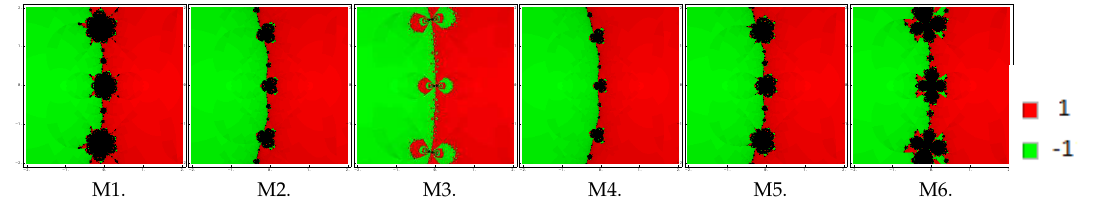
Figure 1. Basins of attraction for polynomial P 1 ( z ) for β = 10 − 2 .